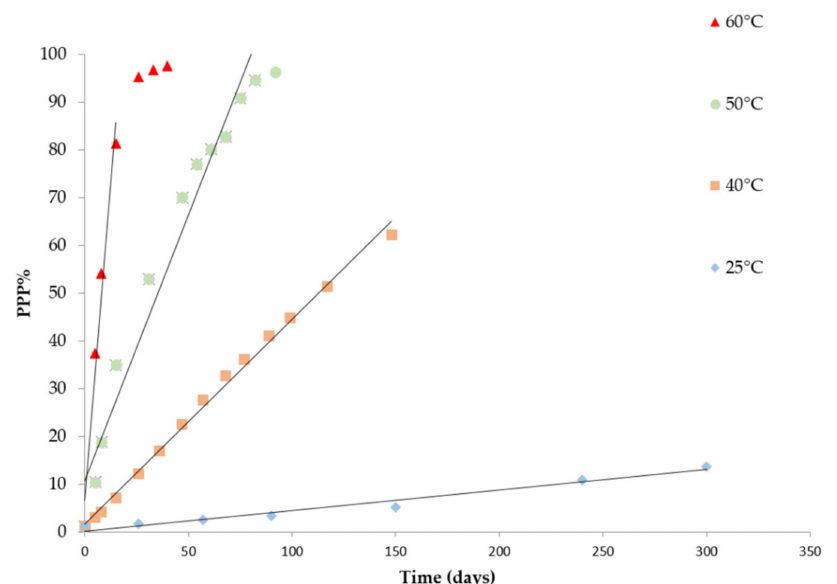
Figure 2. Changes of %PPP of extra virgin olive oil stored at 25, 40 50 and 60 ◦ C (symbols: experimental data, solid line: regression results).